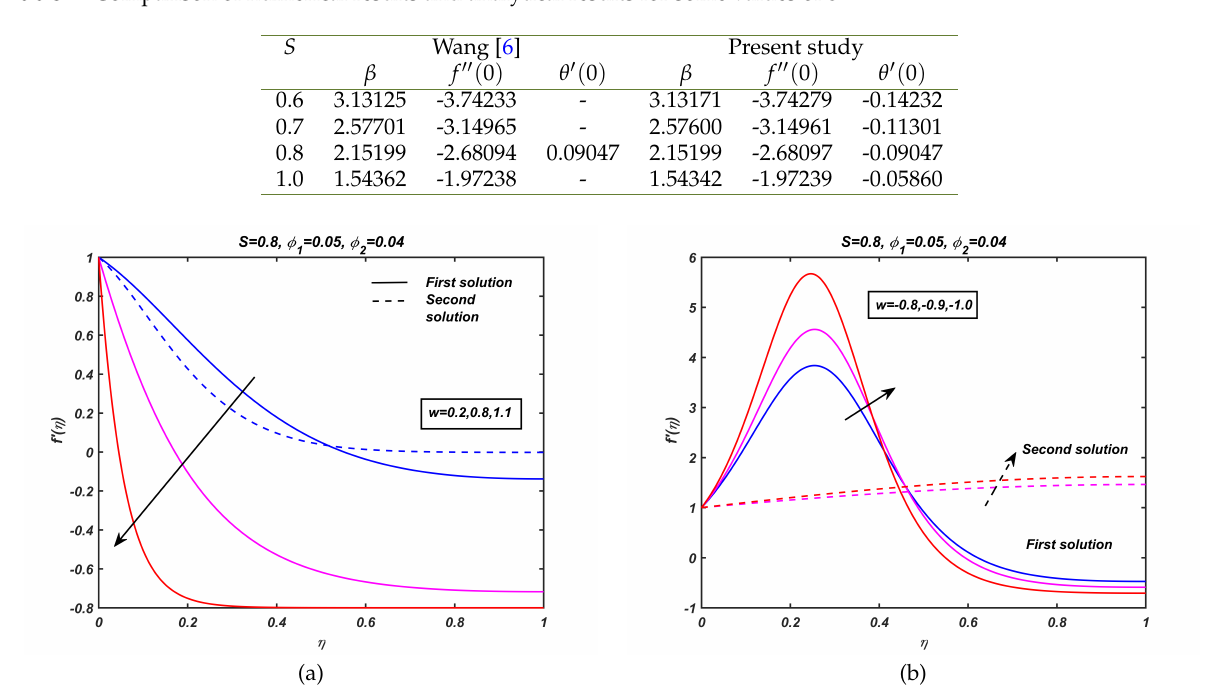
Fig. 2. Effect of S on velocity for suction case (a) and injection case (b) Table 2. Comparison of numerical results and analytical results for some values of S